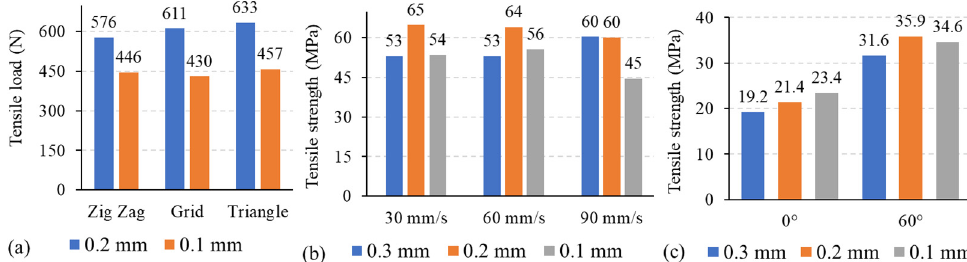
Figure 3. ( a ) PLA strength sensitivity to layer thickness (mm) with different infill patterns, ( b ) PLA strength sensitivity to layer thickness with different extrusion speeds (mm/s), and ( c ) PLA strength sensitivity to layer thickness with different raster angles (in